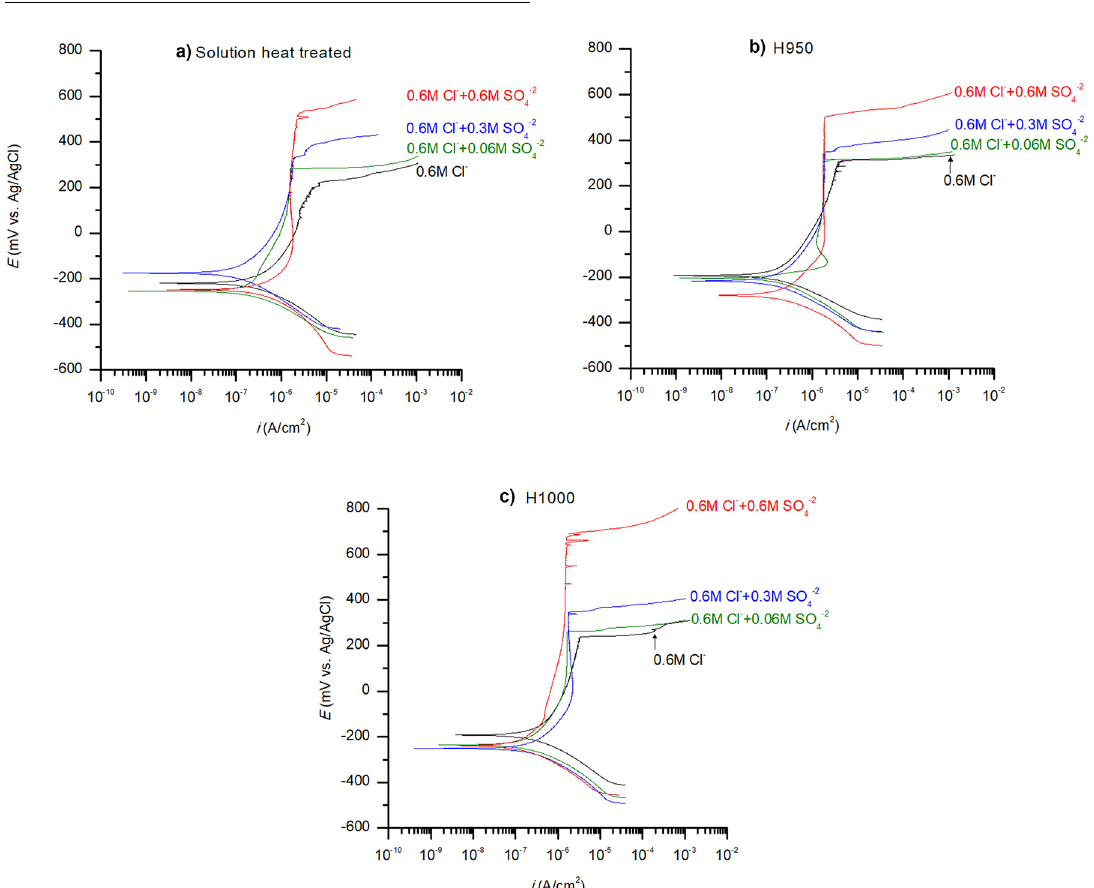
Figure 9. Potentiodynamic polarization curves of UNS S46500 steel on conditions: (a) solution heat treated; (b) H950 and (c) H1000; with increased sulfate additions.